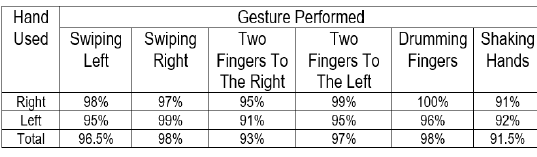
Table 2. Analysis of the gesture